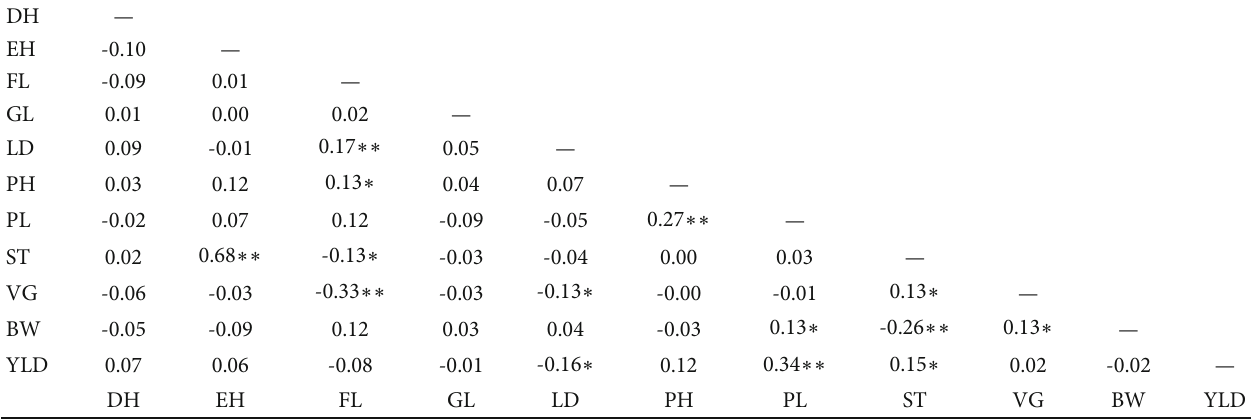
Table 11: Correlation coe ffi cients between C. partellus damage and agro-morphological traits at Kiboko